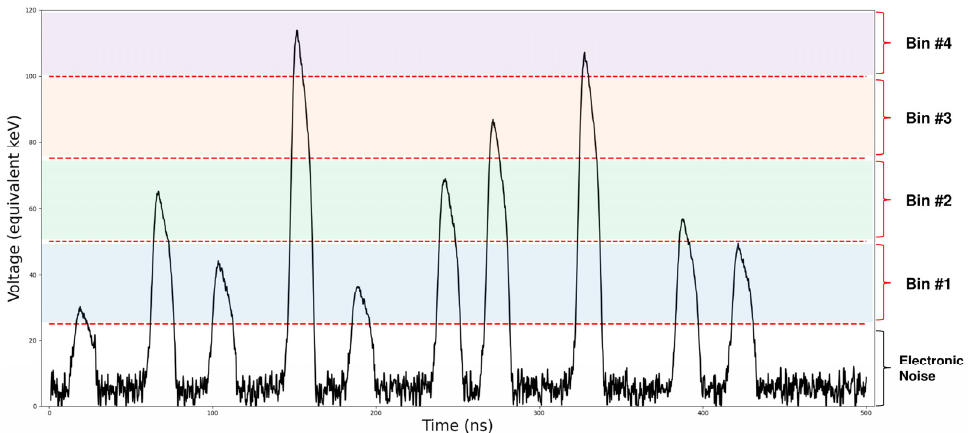
Figure 2. (cid:31)xample of a 500 ns signal output of a photon-counting detector pixel. Figure 2. Example of a 500 ns signal output of a photon-counting detector